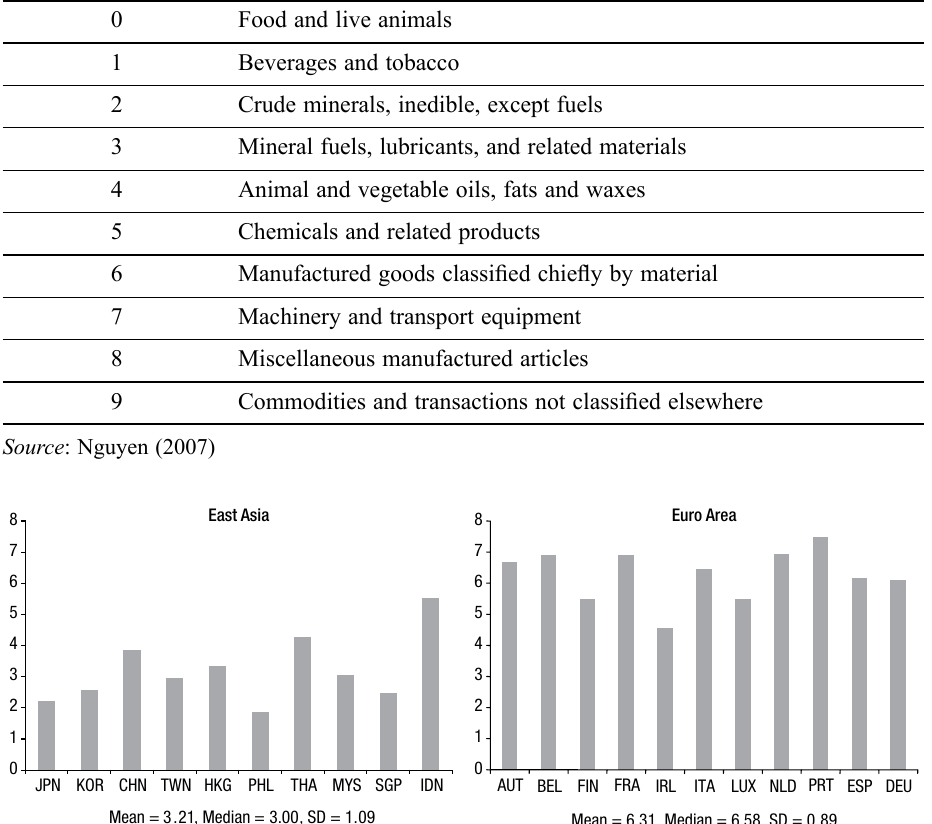
Fig. 7. Export diversification index,